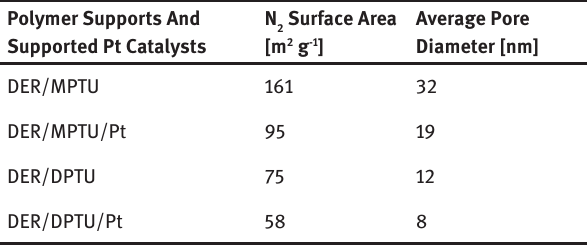
Conditions: Temperature 80˚C, time 4 h; [CALC]:[Pt]=18; solvent: 96% ethanol; the overall volume: 5.5 mL; unidentified reaction products are not shown. Table 3: BET Data for the support and supported Pt catalysts. Polymer Supports And Supported Pt Catalysts